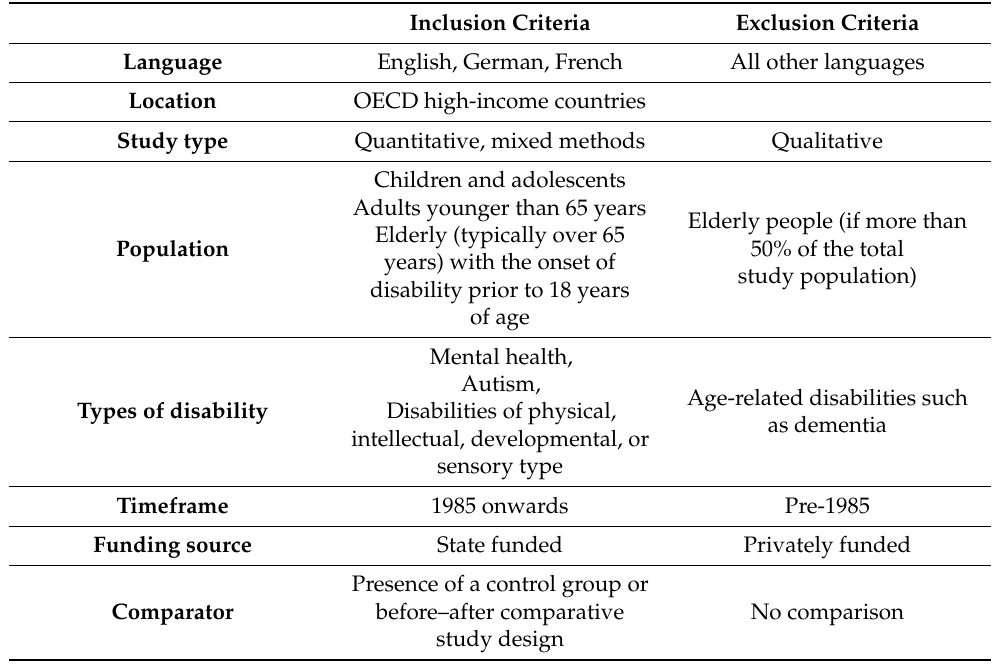
Table 1. Summary of inclusion and exclusion criteria for